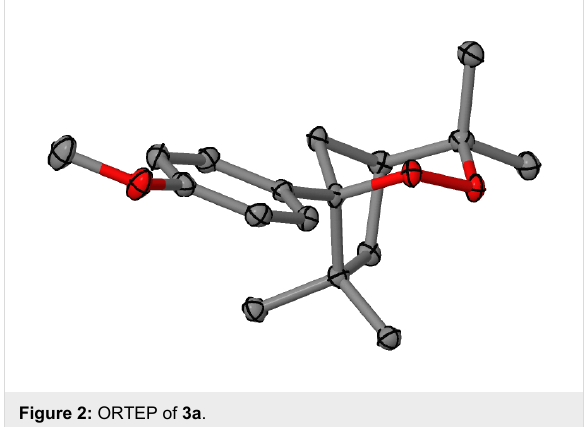
Figure 2: ORTEP of 3a